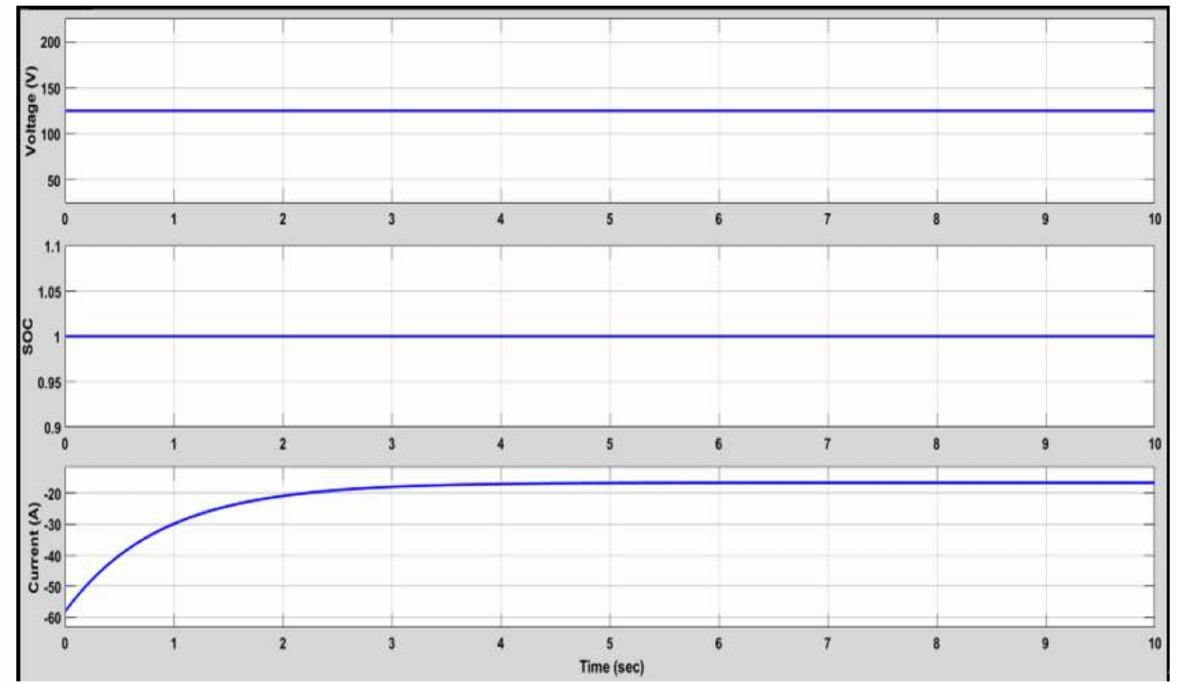
Figure 8. Performance measures of the EV while discharging.